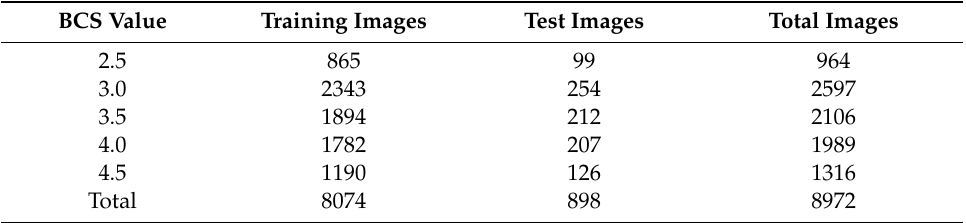
Figure 4. Percentage of BCS values distribution over training and test set in Cow Tail Dataset (CTD). Table 1. Body condition scores (BCS) values distribution for training and test images.